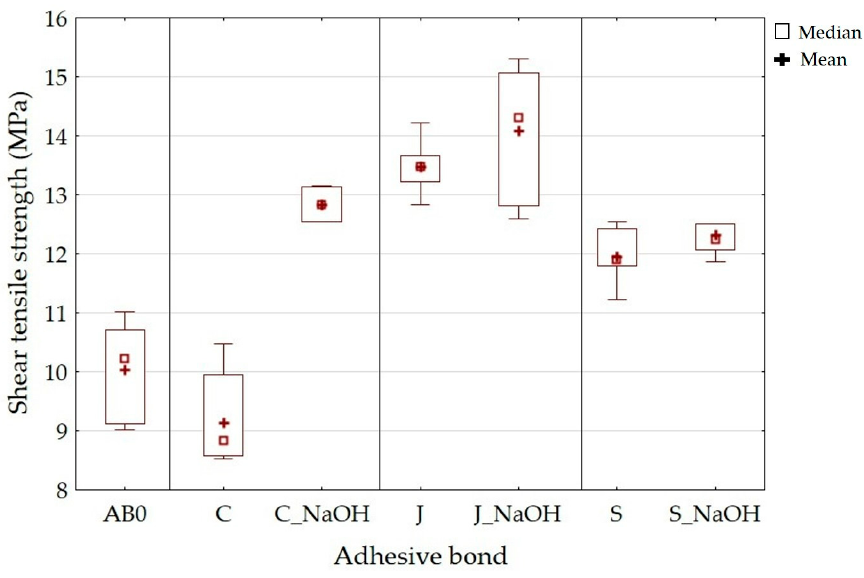
Figure 6. Static tensile test—shear tensile strength.